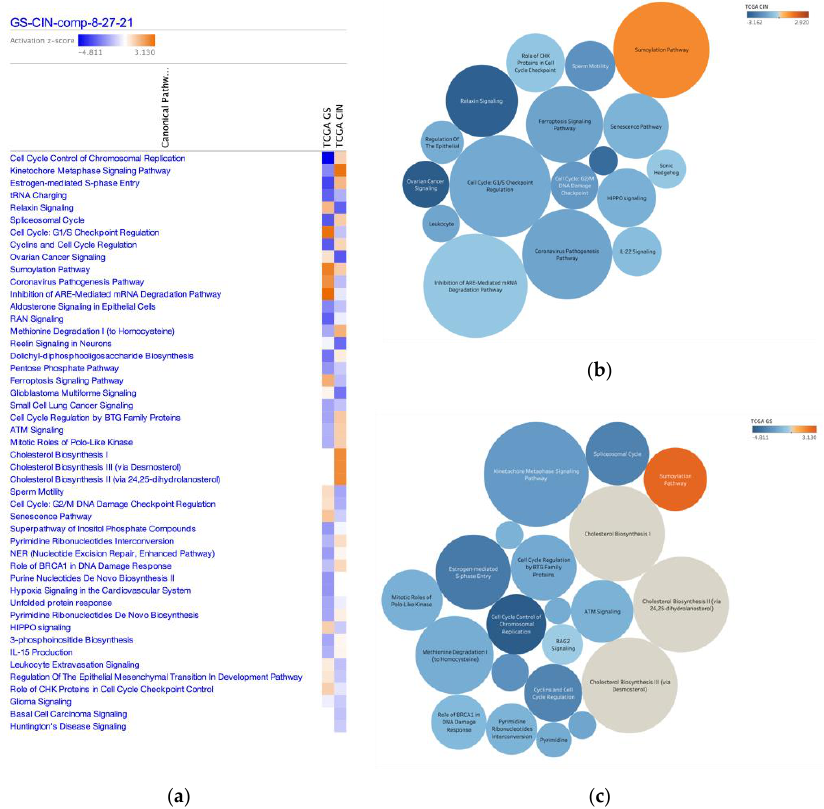
Figure 1. Canonical pathways altered in diffuse- and intestinal-type GC. ( a ) Canonical pathways with an absolute z-score of >1 for diffuse- and intestinal-type GC are shown (TCGA GS; diffuse-type GC, TCGA CIN; intestinal-type GC) ( b ). The size of each circle shows the activation score in diffuse-type GC. Color indicates the activation score in intestinal-type GC. ( c ) The size of each circle indicates the activation z-score for intestinal-type GC. Color indicates the activation z-score of intestinal-type